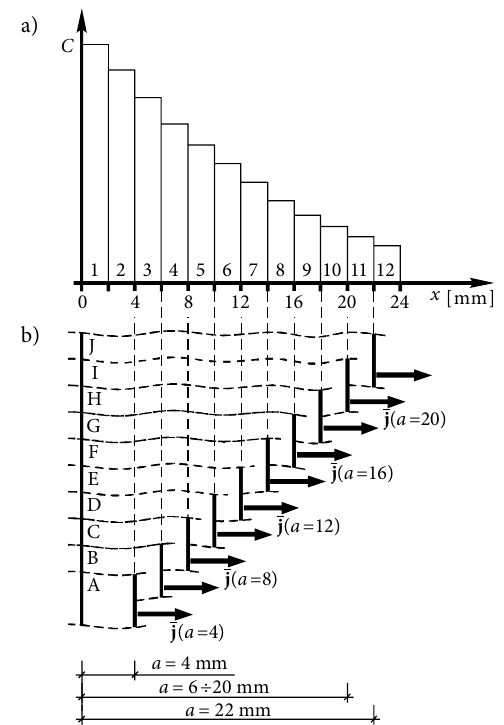
Fig. 3. Pattern of calculation: a) distribution of an inhibitor concentration experimentally determined in layered samples, b) analyzed model